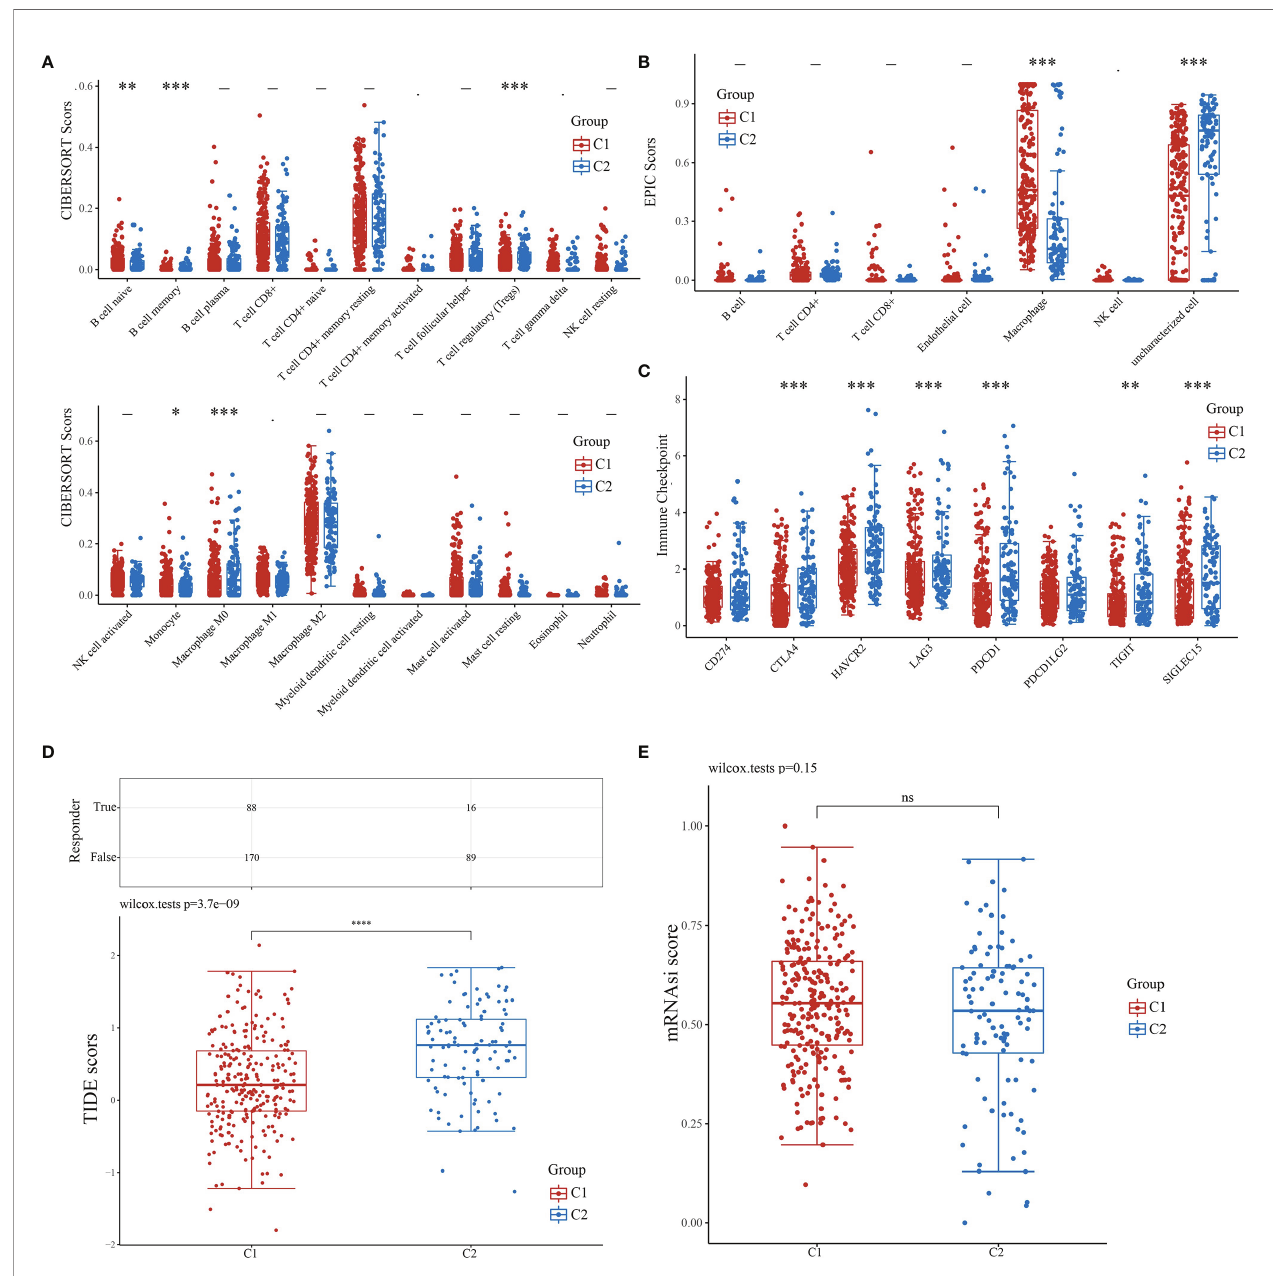
FIGURE 4 | Comparisons of immune status and stemness between C1 and C2. (A, B) Comparison of C1 and C2 in immune in fi ltration obtained using CIBERSORT and EPIC algorithm. The horizontal axis represents different immune cells; the vertical axis represents the immune scores (* P <0.05, ** P <0.01, *** P <0.001). (C) Comparison of immune-checkpoint gene expression in C1 and C2. The horizontal axis shows different immune checkpoint genes; the vertical axis shows the expression level (* P <0.05, ** P <0.01, *** P <0.001). (D) Statistical table showing immune response and the distribution of immune response scores of the different groups with the predicted outcome. (E) Comparison of C1 and C2 in stemness demonstrated with mRNAsi score using the OCLR